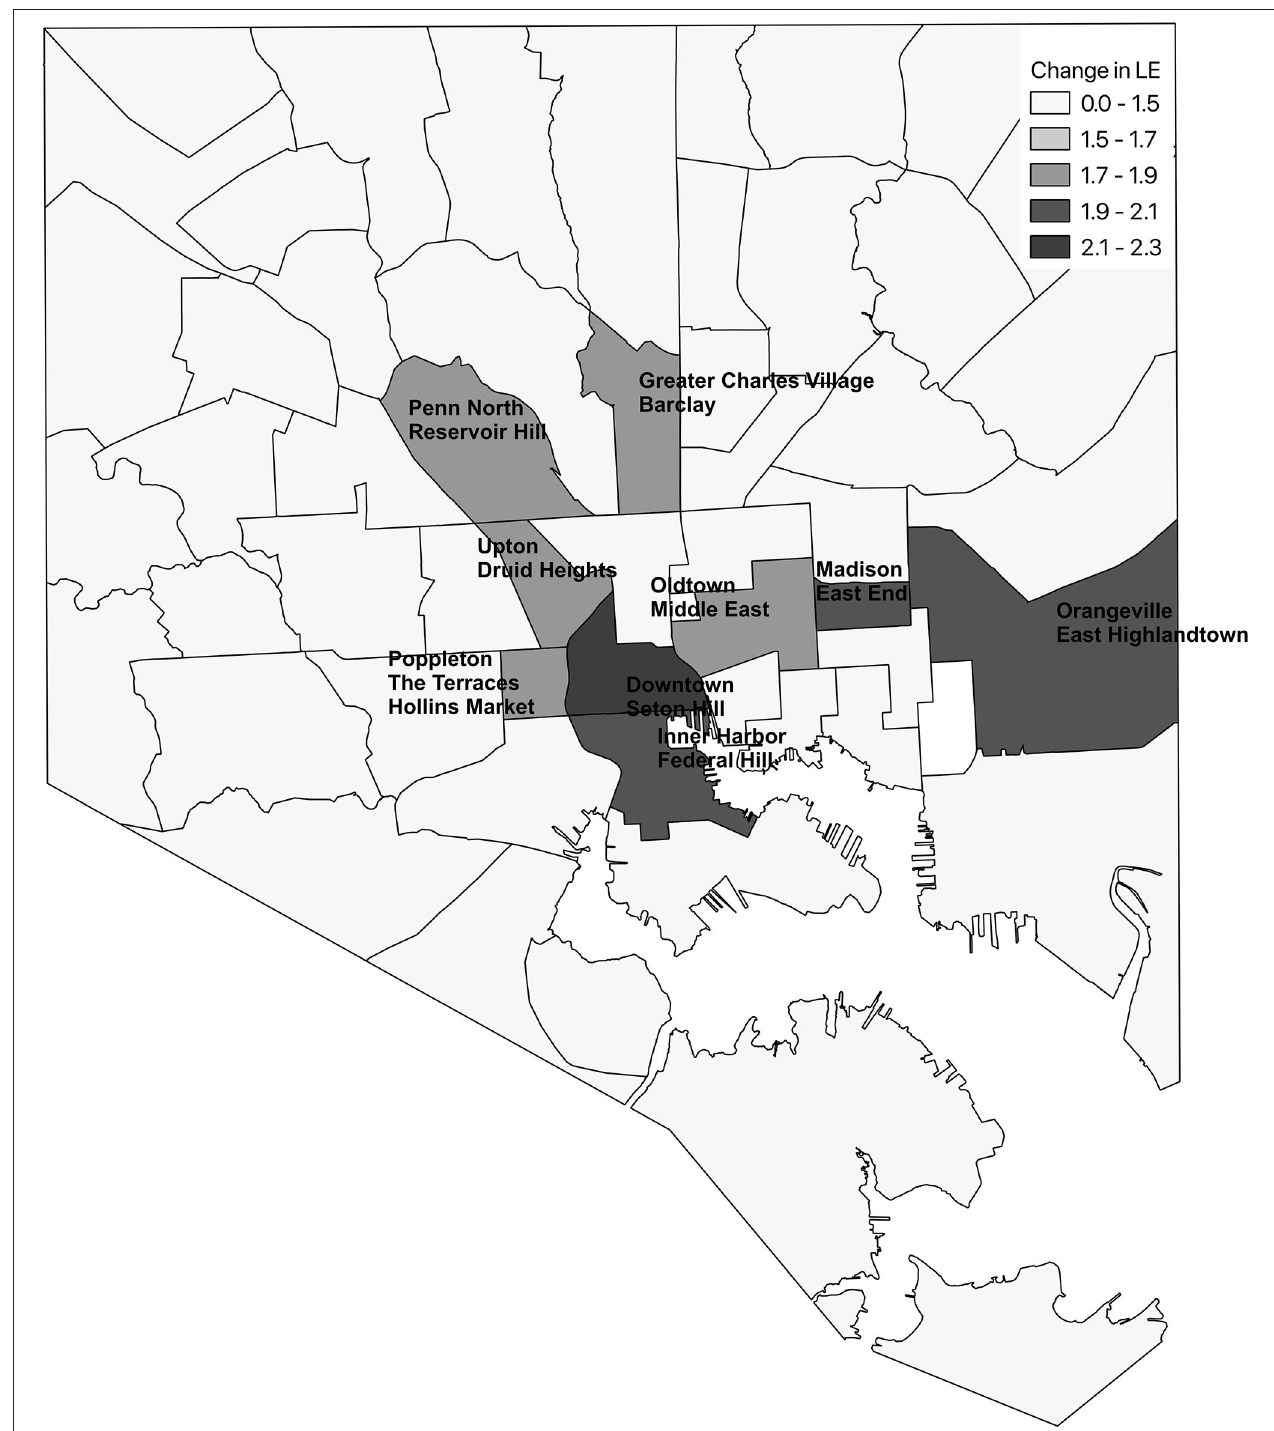
FIGURE 1 | Ten Baltimore city community statistical areas (CSAs) with highest crude heart disease mortality (A) and ten CSAs with greatest potential increase in life expectancy following a 20% reduction in heart disease deaths (B) .